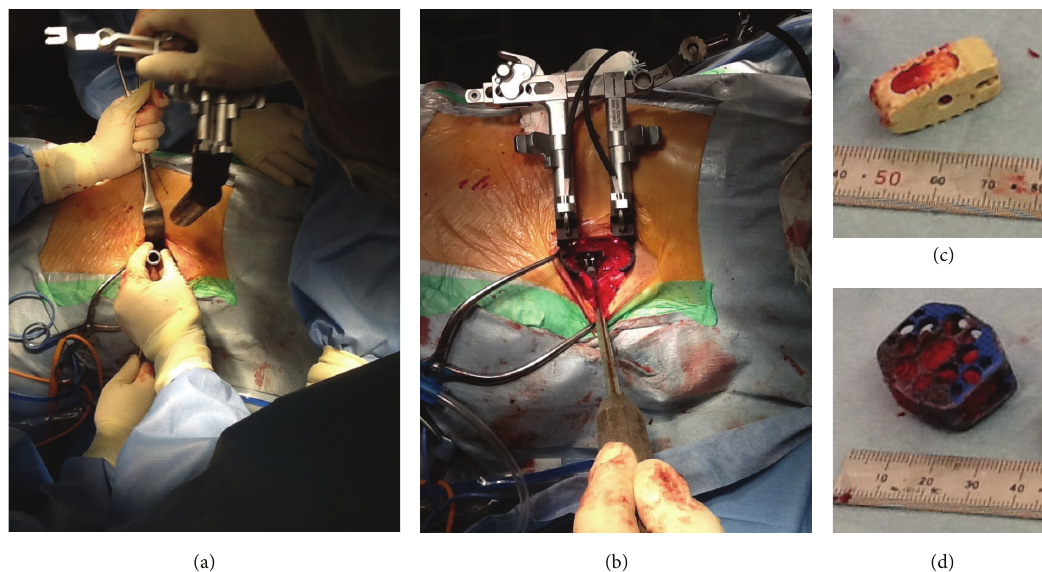
Figure 2: ((a) and (b)) Dilators were used at first, and, next, retractors with light were used. (c) Removed cage. (d) Insertion of the SynCage.